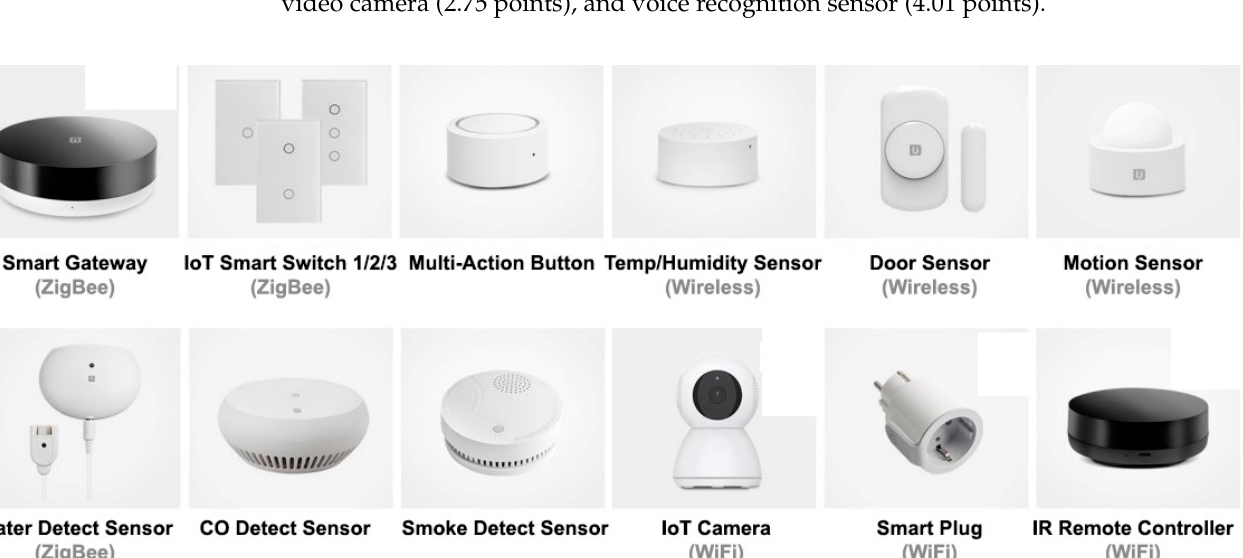
Table 9. Location of Smart Home Technology and Sensors.